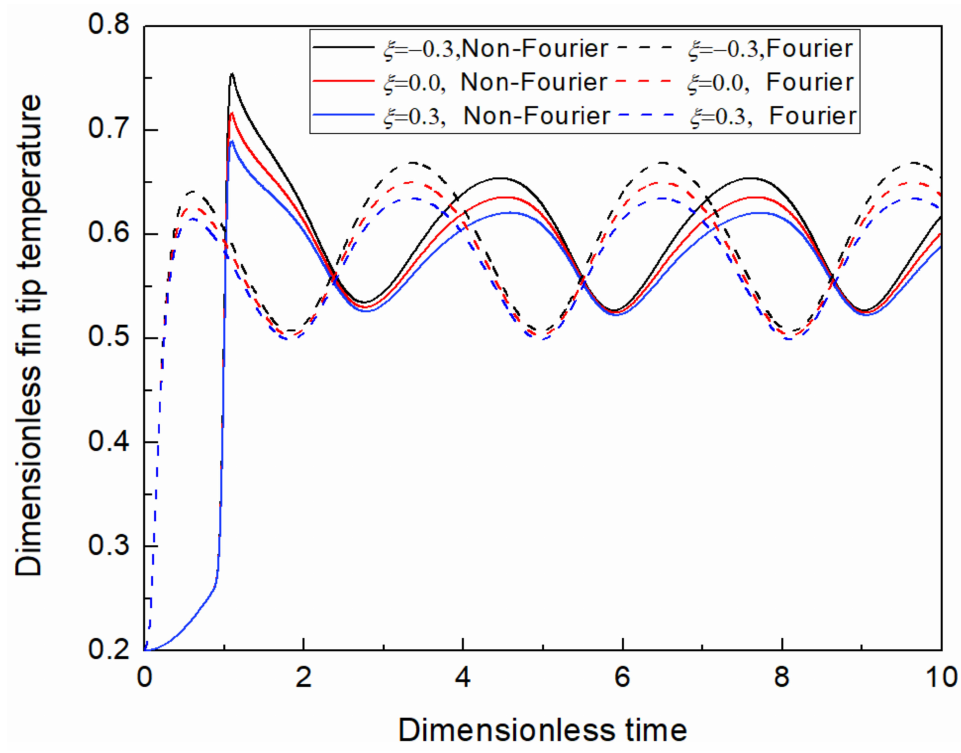
Figure 13. The variation of fin tip temperature at different values of ξ .